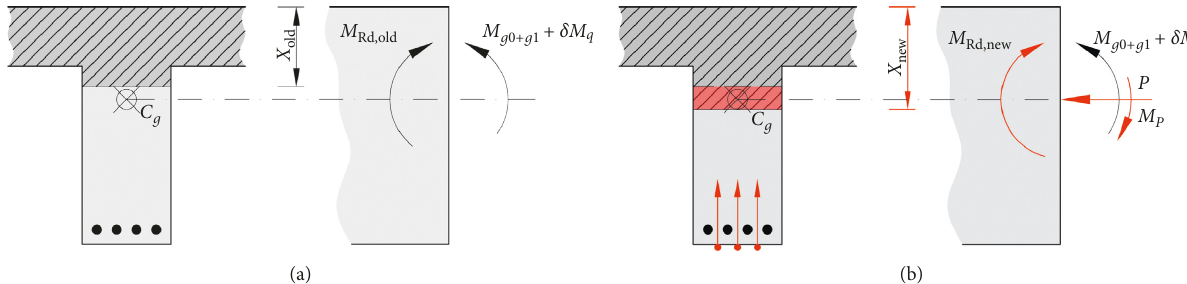
Figure 12: Expression of the prestressing effect on the beam structure cross section. The beam cross section and its internal forces (pure bending) (a) before and (b) after application of prestressing force. The cross section is now eccentrically in compression (a combination of bending moments and axial force), thus increasing the load-bearing capacity of the cross section.